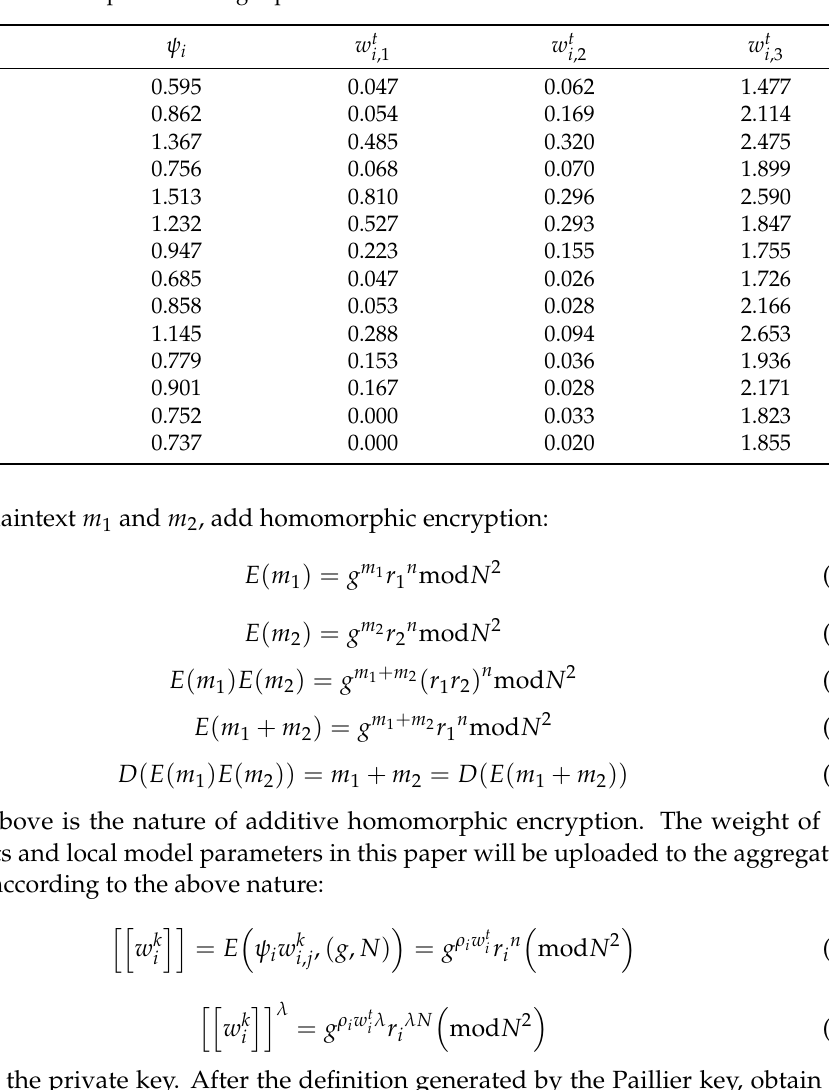
Table 5. Global model plaintext weight